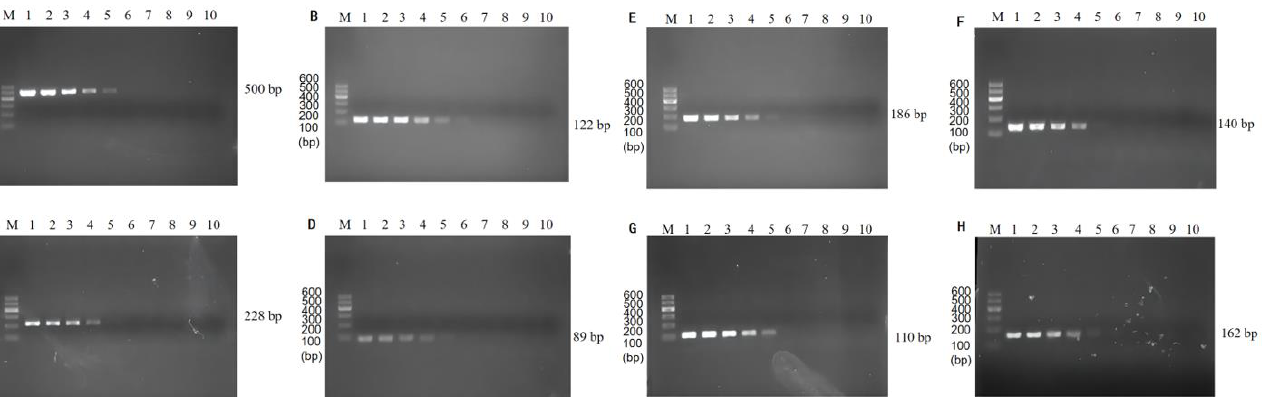
Figure 2. Multiplex PCR amplification at the different annealing temperatures. Lane M: DNA marker B 600; Lane 1~11: Annealing temperature is 48 °C, 49 °C, 50 °C, 51 °C, 52 °C, 53 °C, 54 °C, 55 °C, 56 °C, 57 °C, and 58 °C, respectively.